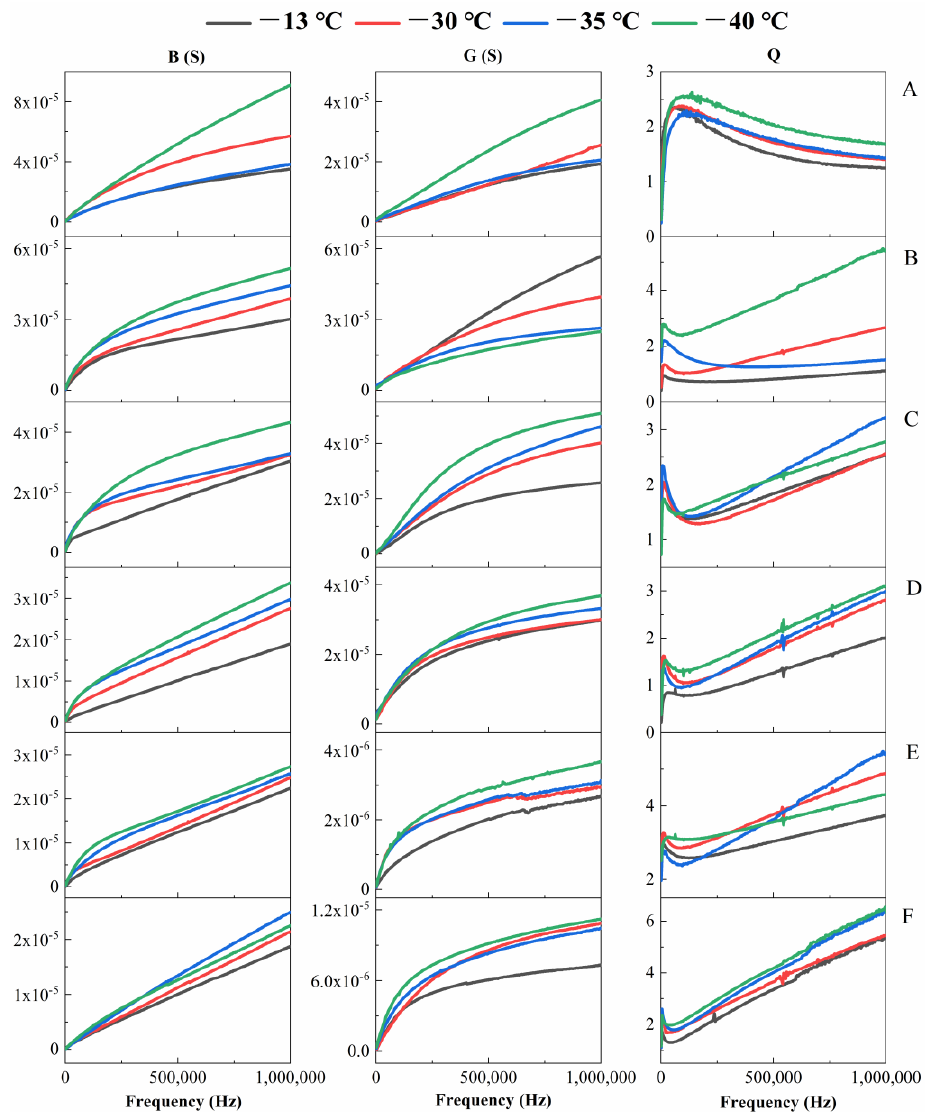
Figure 5. Effects of different freezing times and temperatures on the susceptance B, conductance G and quality factor Q of sea buckthorn berries. (( A ), 0 d; ( B ), 15 d; ( C ), 30 d; ( D ), 45 d; ( E ), 60 d; ( F ), 75 d). The data are mean values of five replicates.